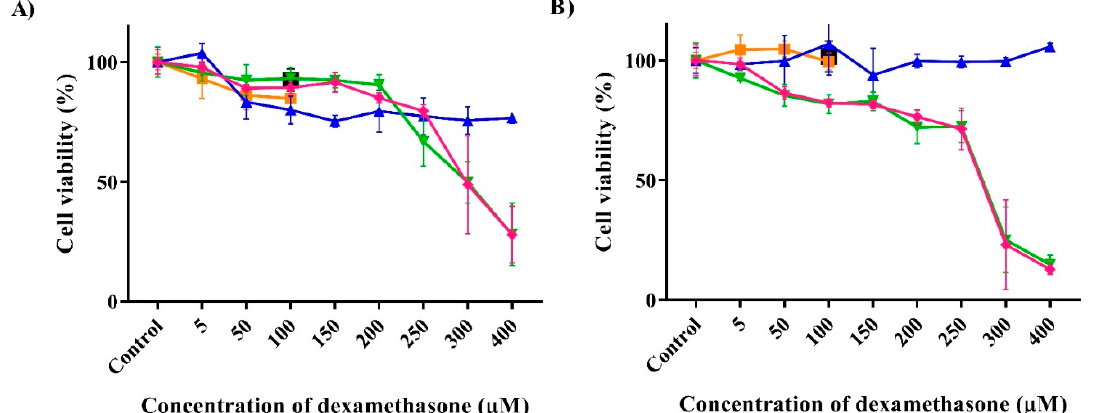
Figure 6. ARPE-19 cell viability profiles by MTT assays ( A ) after 24 h incubation with samples, and ( B ) after 24 h incubation followed by removal of samples and 48 h cell proliferation. Control are untreated cells (negative control, no polymeric conjugate or drug added), DMSO in the medium (0.8% v / v , one black squared symbol, ■ ), dexamethasone (positive control, ■ ) and carboxyhydrazide-pullulan as drug-free polymer ( ▲ ), pullulan-dexamethasone ( ▼ ) and fluorescently labeled pullulan-dexamethasone-cyanine3 ( ♦ ). The concentration of free dexamethasone or equivalent conjugated dexamethasone in pullulan-dexamethasone is plotted. The concentration of the carboxyhydrazide-pullulan was equivalent to that of pullulan in the cell samples treated with pullulan-dexamethasone.